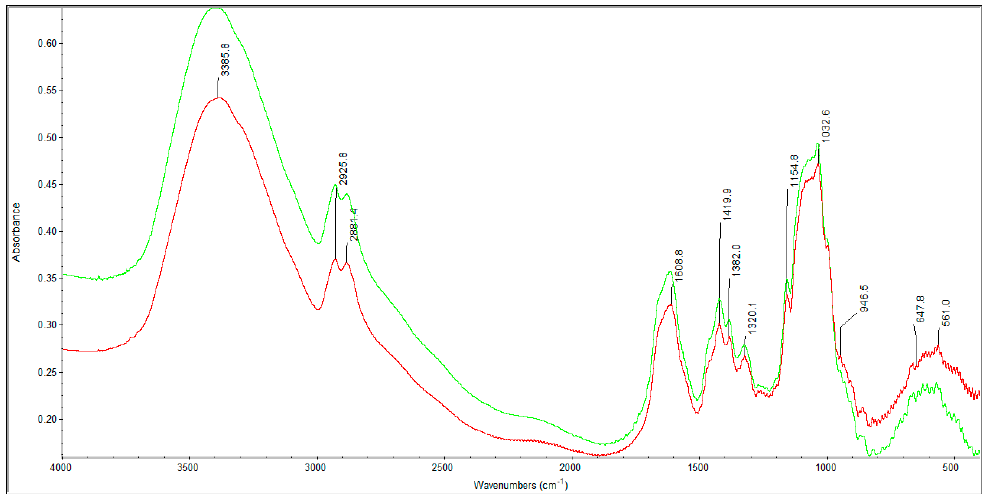
Figure 9. FTIR spectra of the sterilized lyophilized foam before and after the accelerated ageing process: − initial; − after one year of simulated ageing.